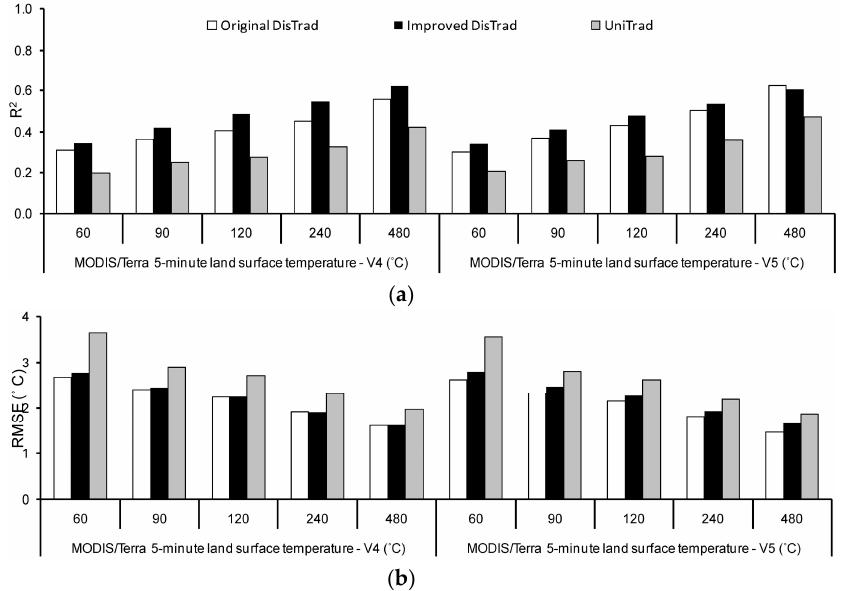
Figure 9. ( a ) coefficient of determination (R 2 ); and ( b ) root mean square error (RMSE) between downscaled products of MODIS 5-min land surface temperature (V4 and V5) and observed Landsat 7 ETM+ land surface temperature at different resolutions (60, 90, 120, 240, and 480 m).